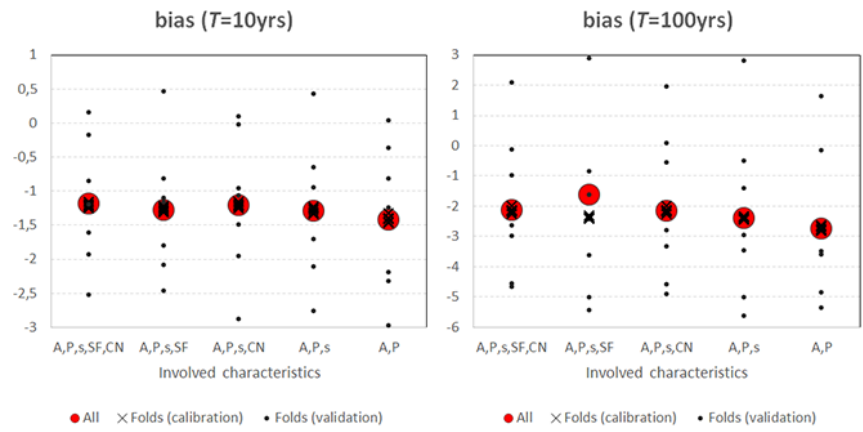
Figure 20. Bias for calibration to the whole data set and for calibration and validation using 7 folds for T = 10 years (left panel) and T = 100 years (right